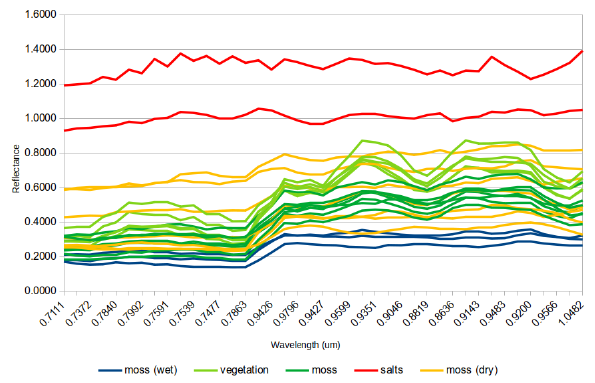
Figure 9 . Spectral signatures derived from the HS images of the Roman Bridge Figures 8 and 9 present spectral signatures from the St.